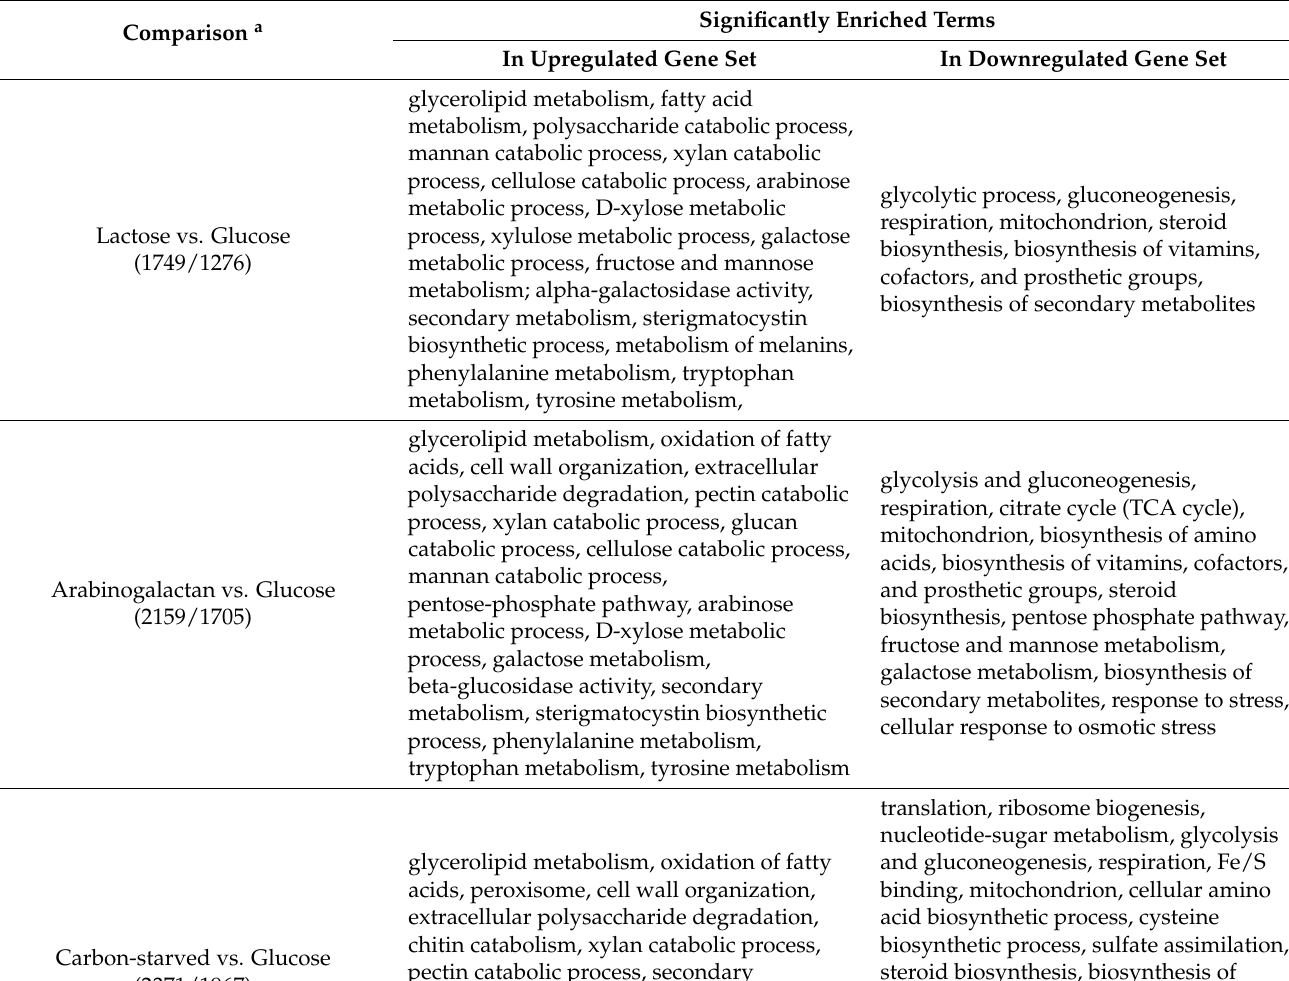
Table 2. Selected significantly enriched FunCat, GO, and KEGG pathway terms of the carbon-stressed A. nidulans